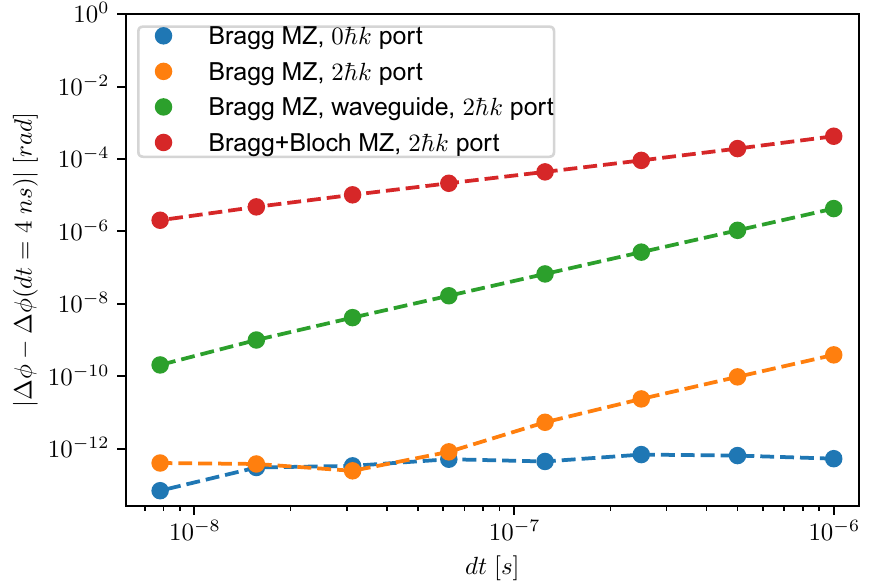
Figure 9. Numerical convergence analysis of three different interferometer realisations given by a 2 (cid:31) k Mach– Zehnder interferometer (blue and orange dots corresponding to the 0 (cid:31) k and 2 (cid:31) k ports), a 2 (cid:31) k Mach–Zehnder interferometer in a waveguide (green dots) and a ( 2 dots). We analyse the numerical convergence behaviour when changing the temporal step dt of the numerical simulation using the third-order split-operator method with a spatial step of dx parameters as Fig. 8 are